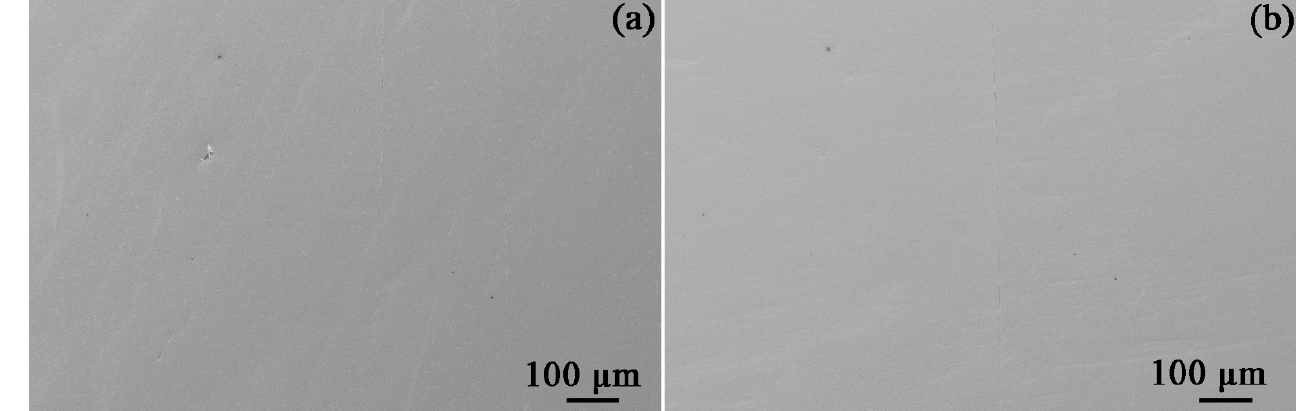
Figure 4. SEM SE images of the API-X100 pipeline steel matrix before ( a ) and after ( b ) exposed to bitumen at 60 °C.